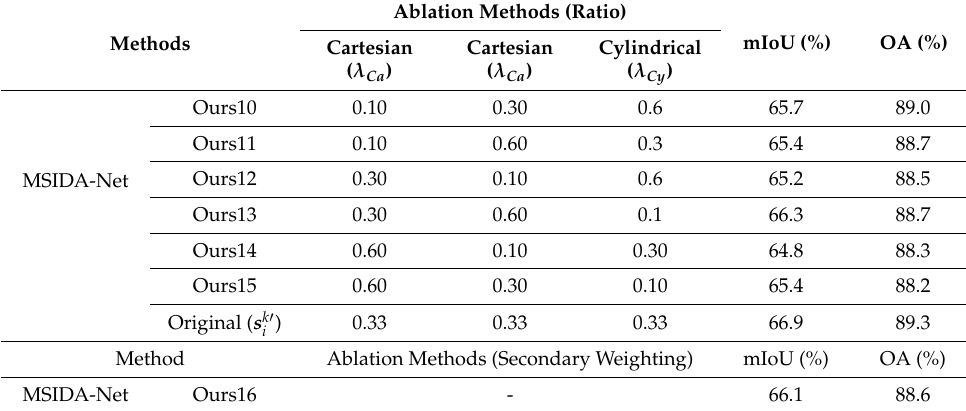
Table 6. The ablation results of attention